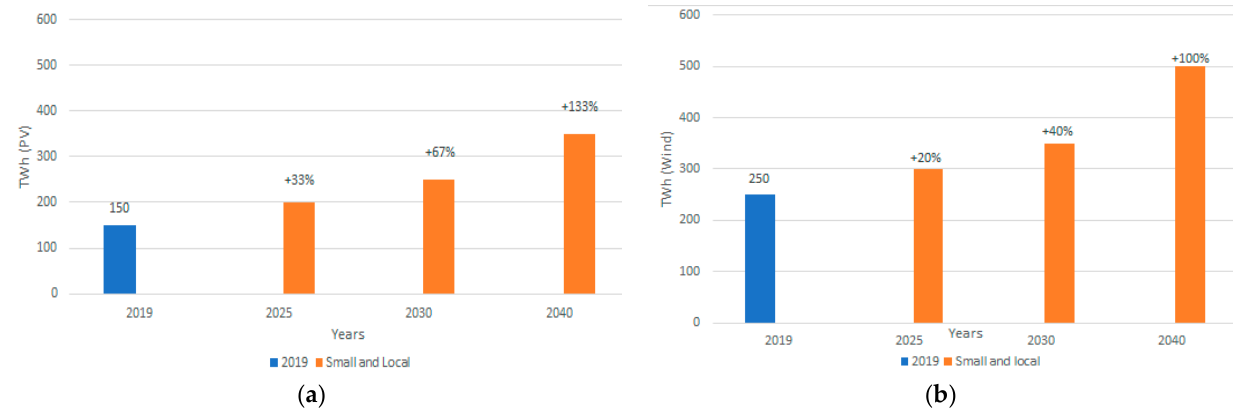
Figure 11. Comparison of energy production for the time horizon 2025, 2030, 2040, with respect to year 2019, for Small and Local scenario: ( a ) PV, ( b ) wind.